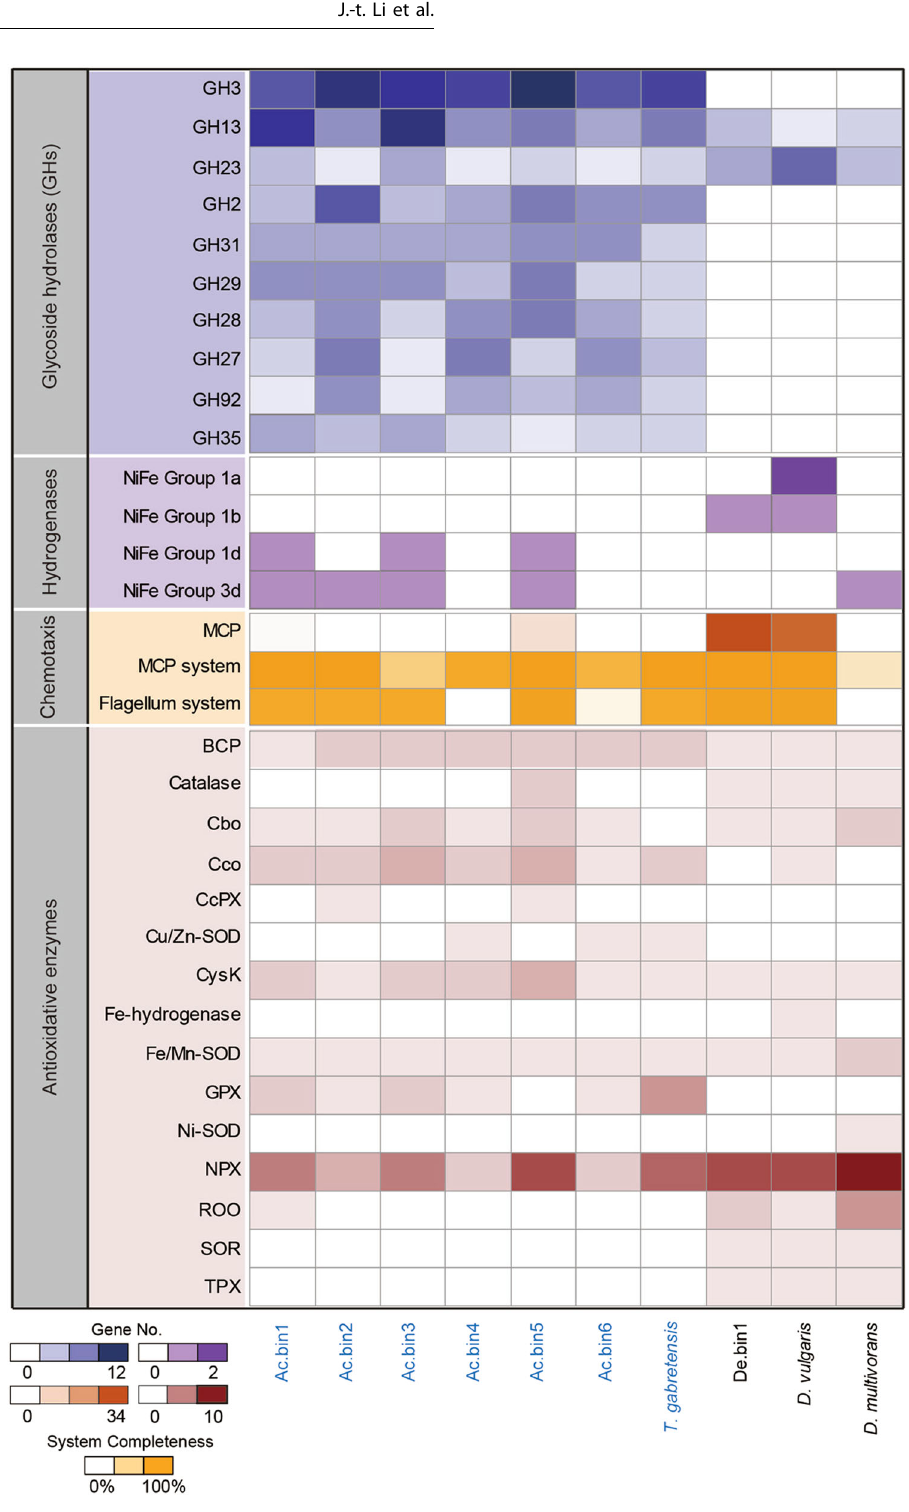
Fig. 2 Comparative analysis of selected metabolic potentials of sulfate-reducing microorganisms (SRMs). Seven high-quality MAGs (completeness >90% and contamination <10%) of SRMs were included in the analysis. For comparison, the complete genomes of one aerobic acidobacterial species (i.e., Terracidiphilus gabretensis S55, non-SRM), Desulfovibrio vulgaris Hildenborough (an oxygen-tolerant cultured model SRM), and Desulfococcus multivorans DSM 2059 (an oxygen-sensitive cultured model SRM) were chosen. The names of acidobacterial genomes are in blue. The 10 most abundant glycoside hydrolase families across the genomes are shown. Those hydrogenase subgroups that are known to be involved in sulfate reduction or to be oxygen tolerant are listed. MCP methyl-accepting chemotaxis protein, BCP bacterioferritin comigratory protein, Cbo cytochrome bd oxygen reductase, Cco cytochrome c oxidase, CcPx cytochrome c peroxidase, SOD superoxide dismutase, CysK cysteine synthase, GPX glutathione peroxidase, NPX NADH peroxidase, ROO rubredoxin-oxygen oxidoreductase, SOR superoxide reductase, TPX thioredoxin peroxidase. Additional details are presented in Supplementary Tables 3 –